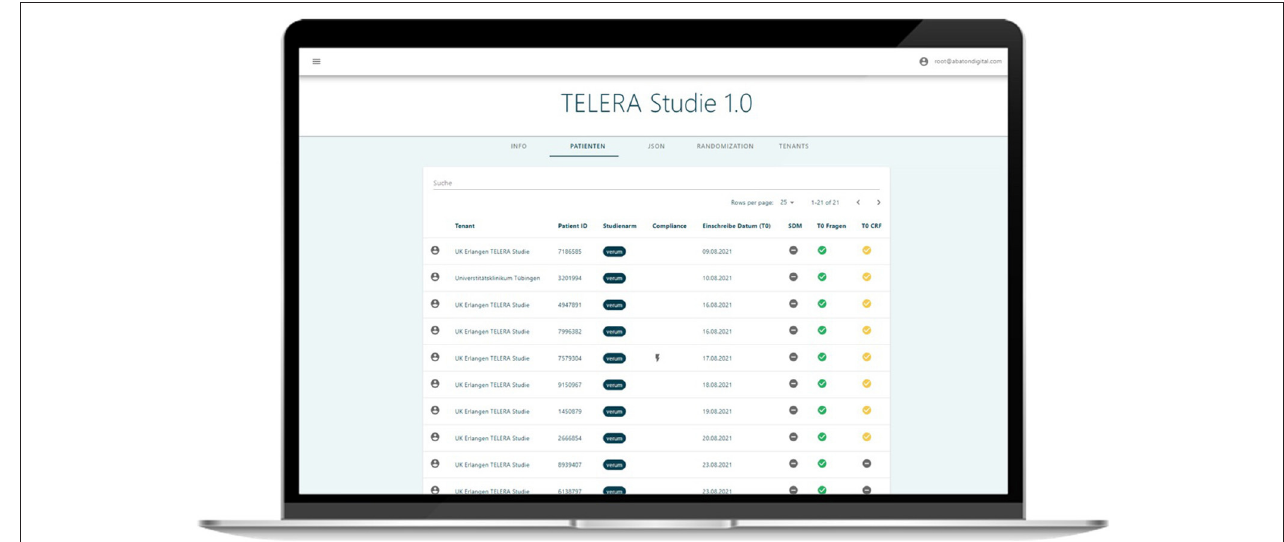
FIGURE 5 | Screenshot of web-based study module displaying overview of the patients’